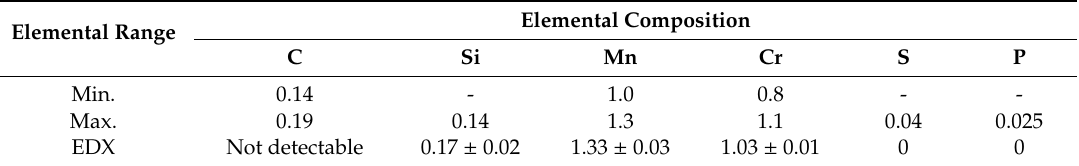
Table 1. Chemical composition of 16MnCr5 according to DIN EN 10084 [11] and measured by means of energy-dispersive X-ray spectroscopy (EDX).